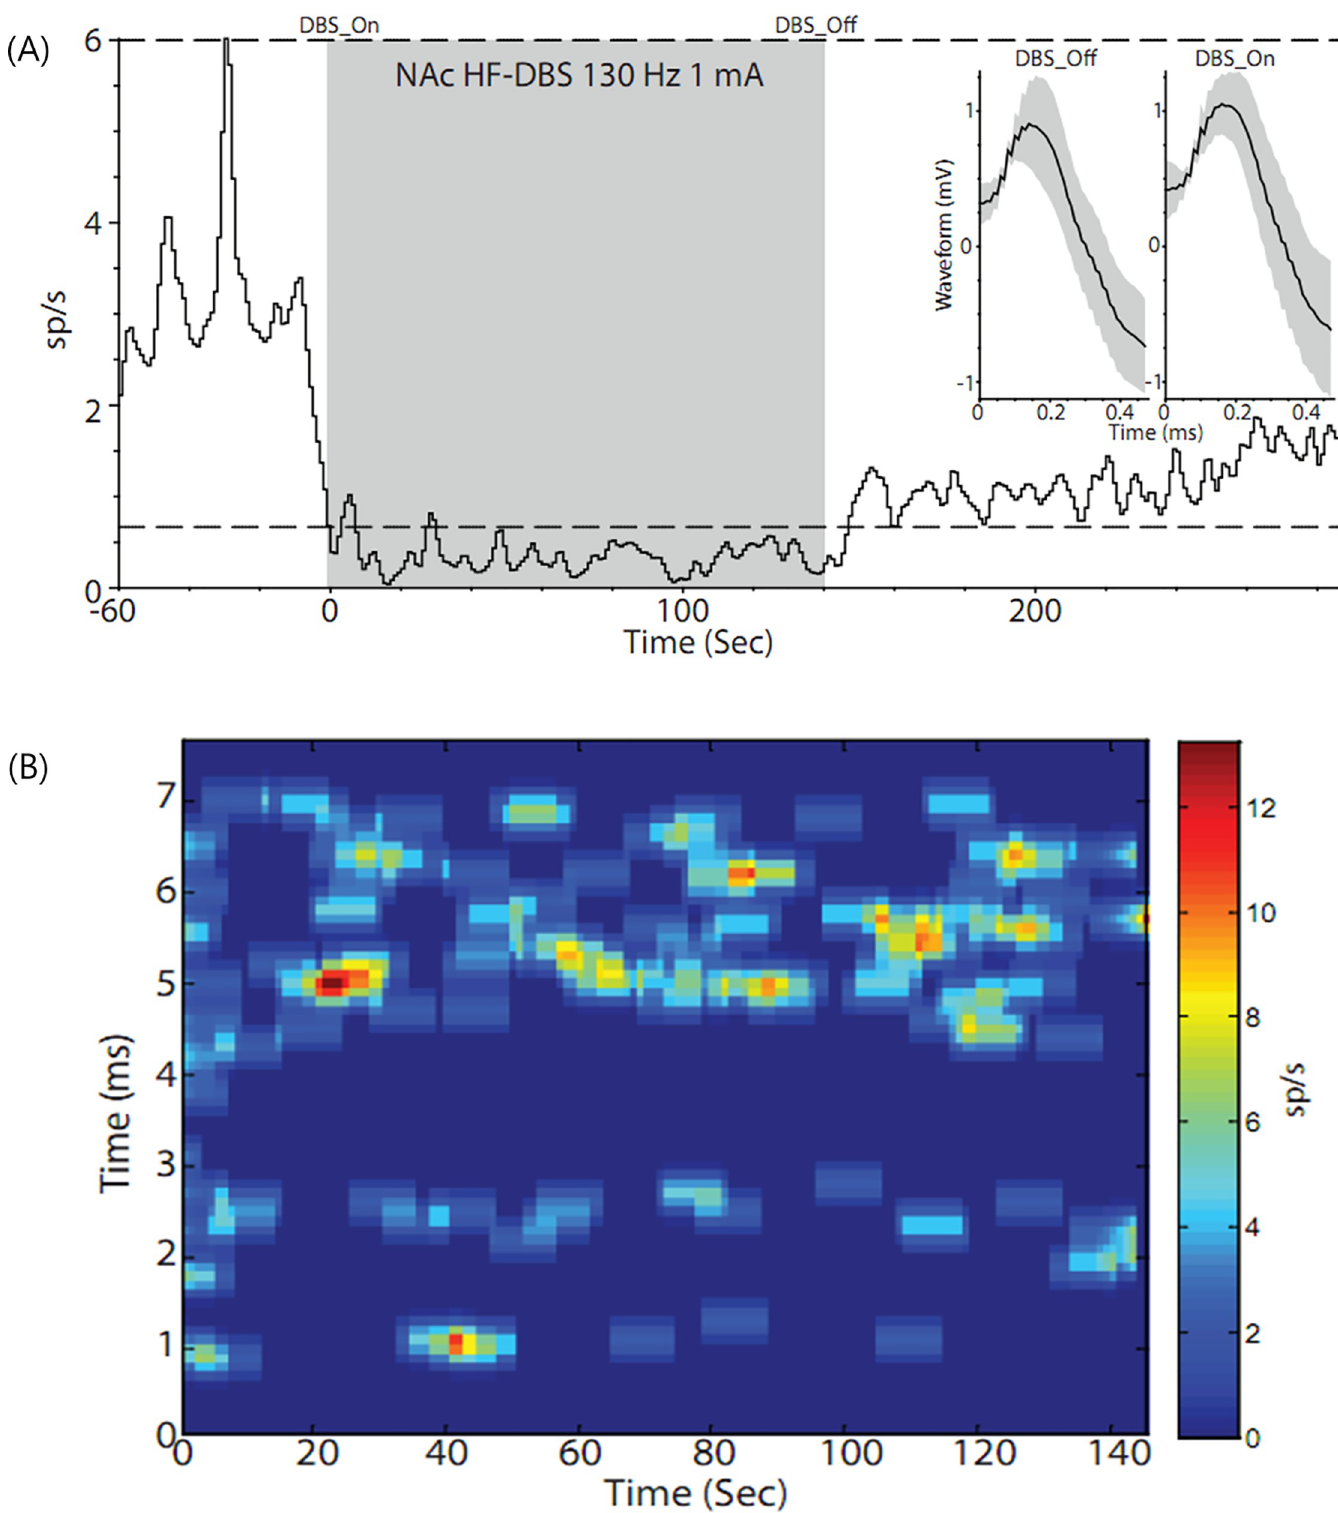
Fig 6. Analysis of the rate firing and neuronal activity. (A) Analysis of the rate firing for one well-isolated unit after extraction of any unwanted voltage transients due to shock artifacts at 1 mA. The figure clearly shows that the mean firing rate (2.93 sp/s SD ± 0.7), drops below the 99% confidence interval calculated from the pre- stimulation period as soon as “DBS_on” is initiated. The units firing rate maintains this reduced activity for the duration of the stimulation period (0.33 sp/s SD ± 0.1